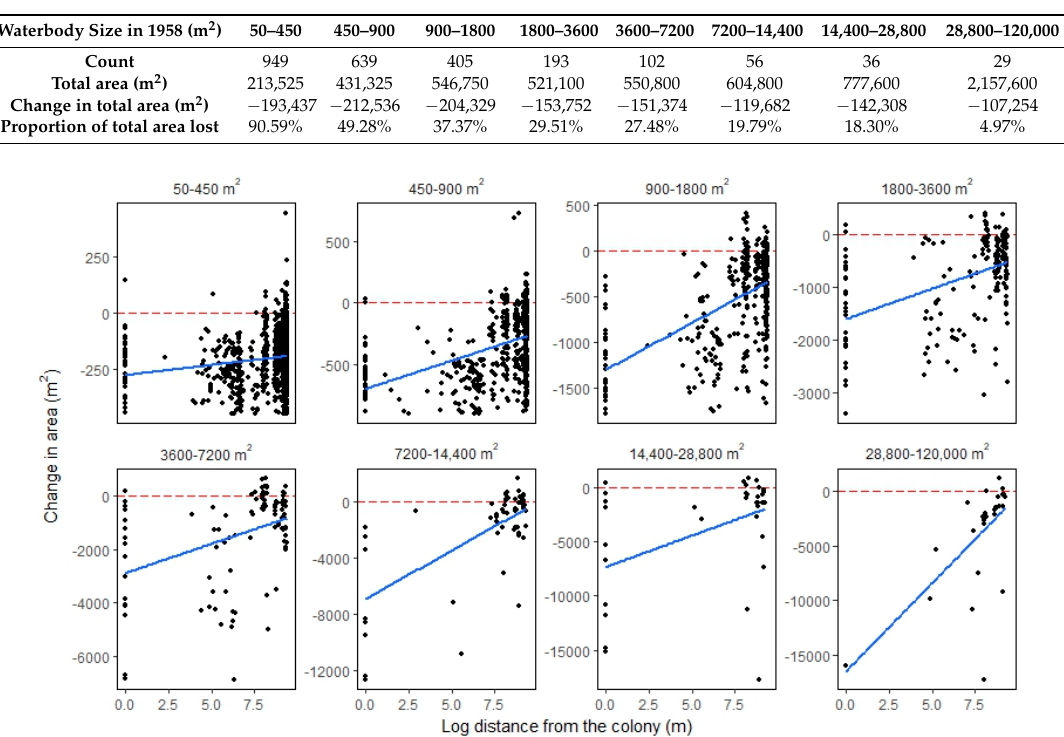
(Table 3). Smaller waterbodies lost a higher proportion of their total area, compared to larger waterbodies (Figure 5). The smallest size class (50–450 m 2 ) lost 90.6% of the total area, compared to the 5% lost by the largest size class (28,800–120,000 m 2 ). Table 3. Summary statistics including the total number, area, change in area, and proportion of change for waterbodies in different size classes.